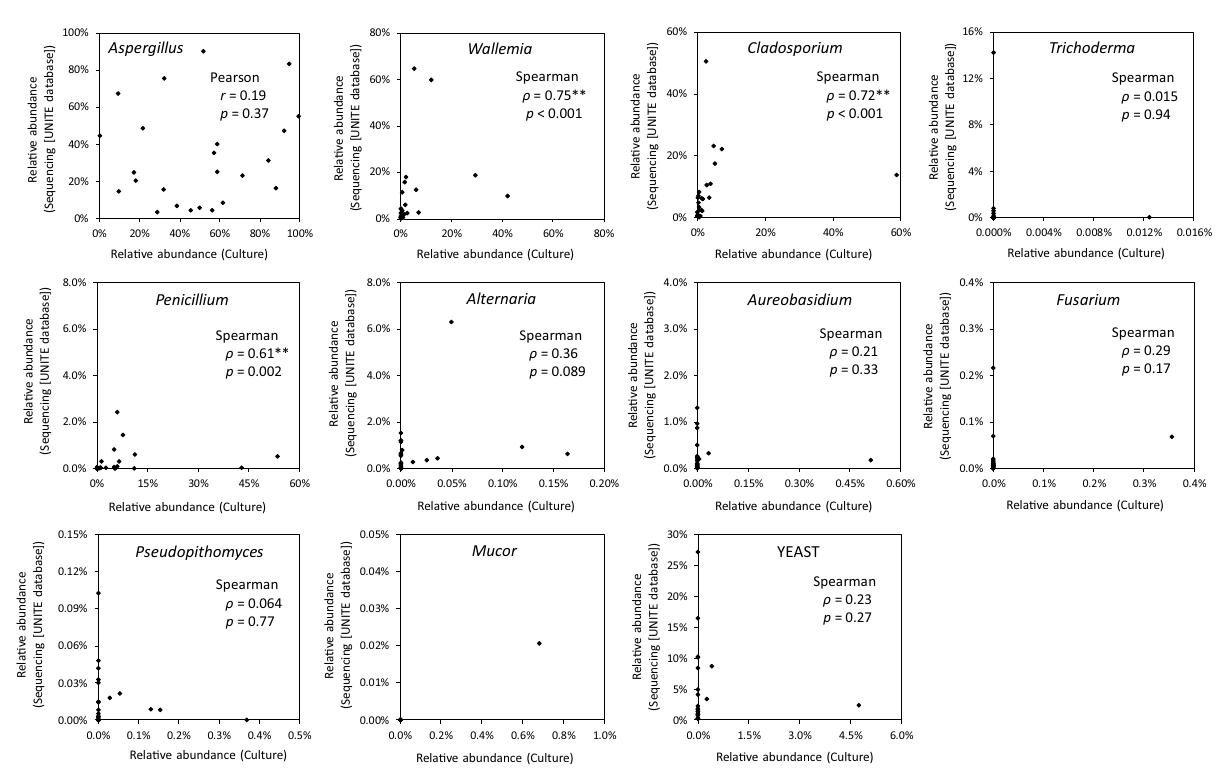
Figure 3. Quantitative comparison of methods. For each fungal genus, the correlation of the relative abundances detected by the culture and sequencing methods is